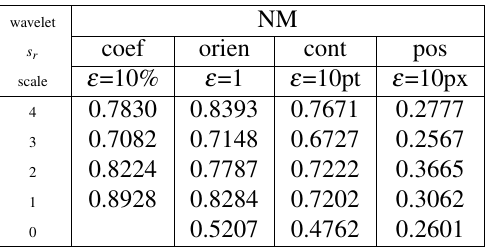
Table 3. B & L Images Comparison.